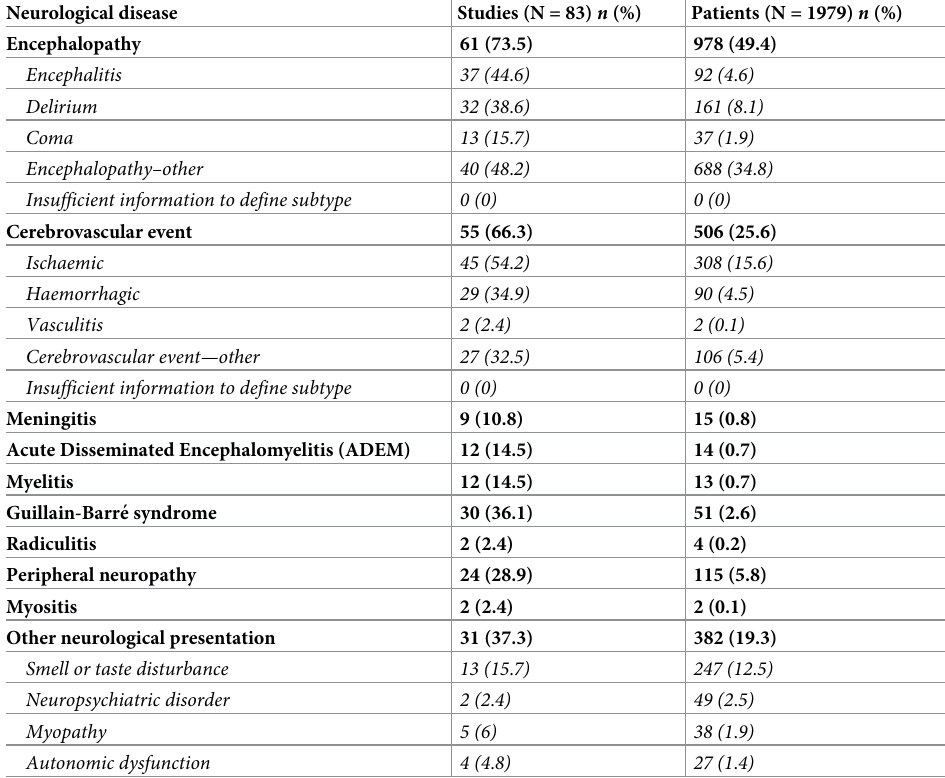
Table 1. Frequency of neurological disease subgroups in the studies contributing